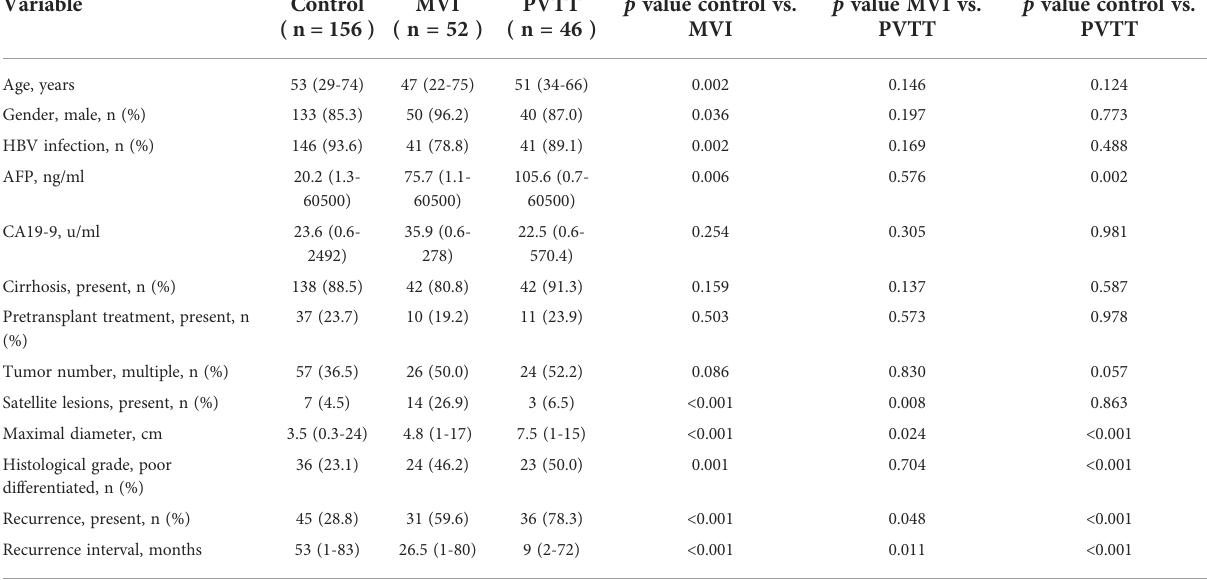
TABLE 2 Comparisons of patients receiving LT with HCC by MVI and PVTT status.